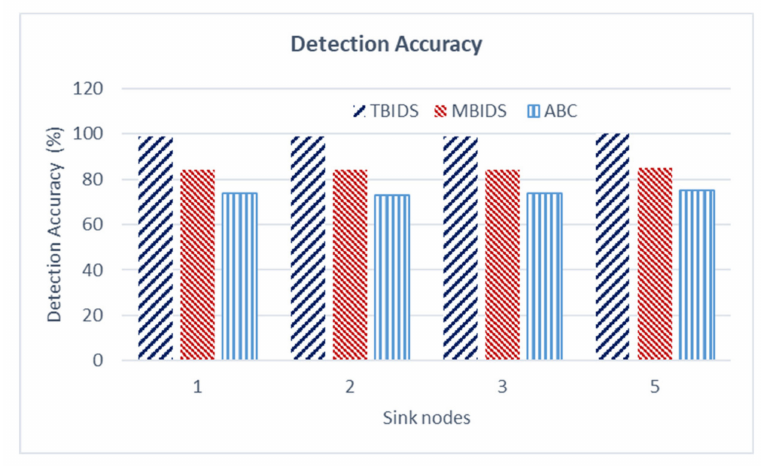
Figure 10. Detection accuracy for a large-scale network with 2, 3, and 5 sink